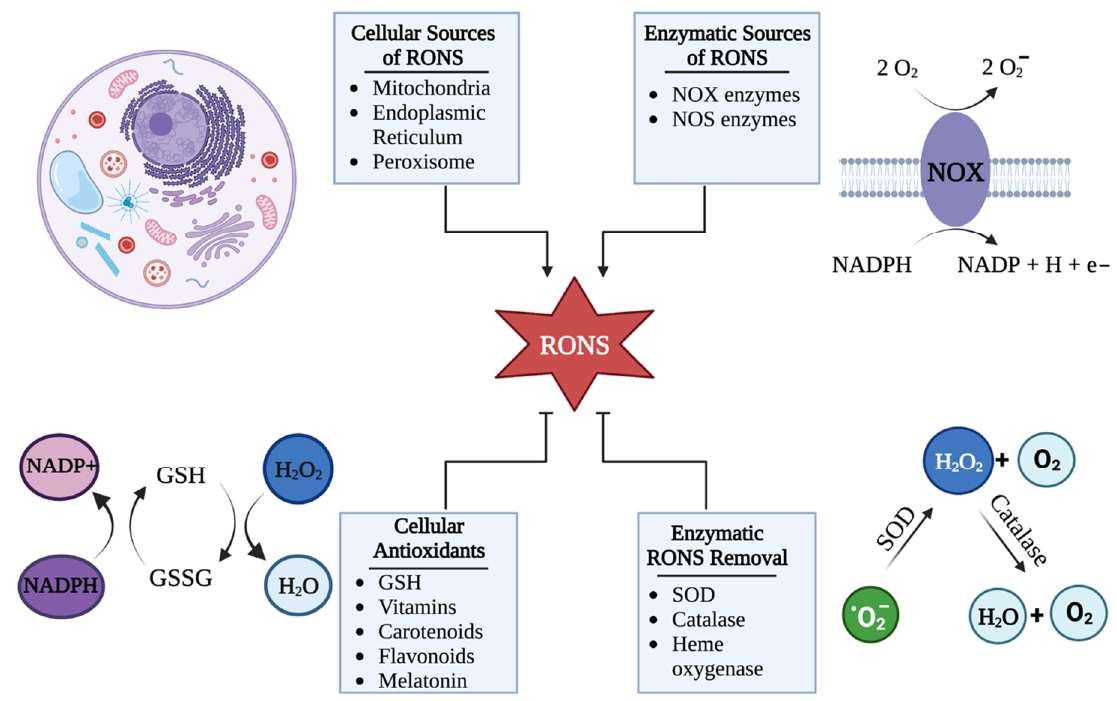
Figure 3. In a cell, RONS can be produced by various organelles during normal metabolic processes including cellular respiration in the mitochondria, protein folding in the ER, and in the peroxisome. Alternatively, enzymes such as NOX and NOS can generate RONS by transporting free electrons across membranes to reduce molecular oxygen. To avoid the accumulation of RONS, cells can oxidize RONS through antioxidants or enzymatically remove them by converting RONS into non-reactive products.